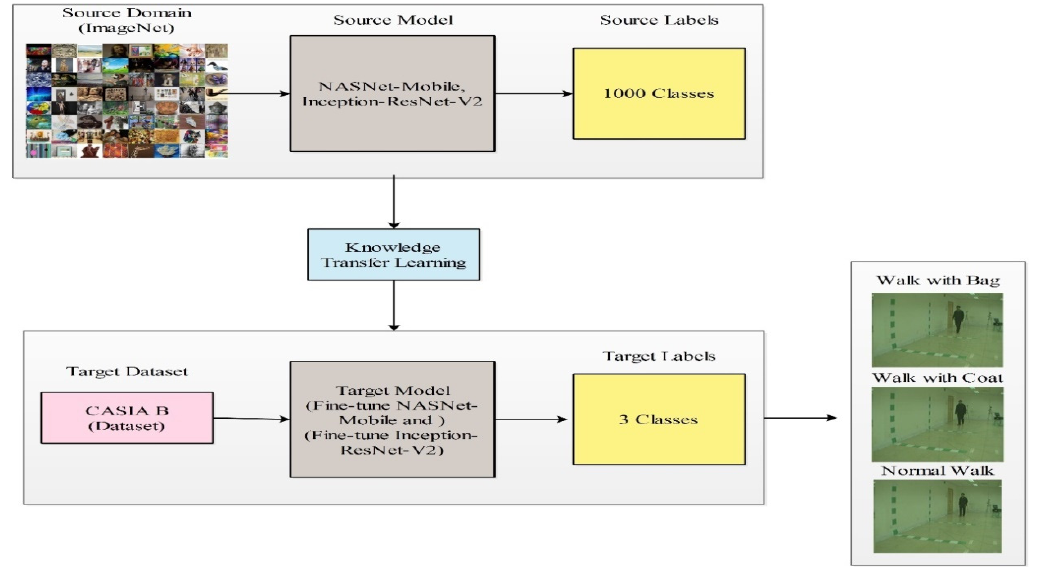
Figure 5. Process of transfer learning for HGR.